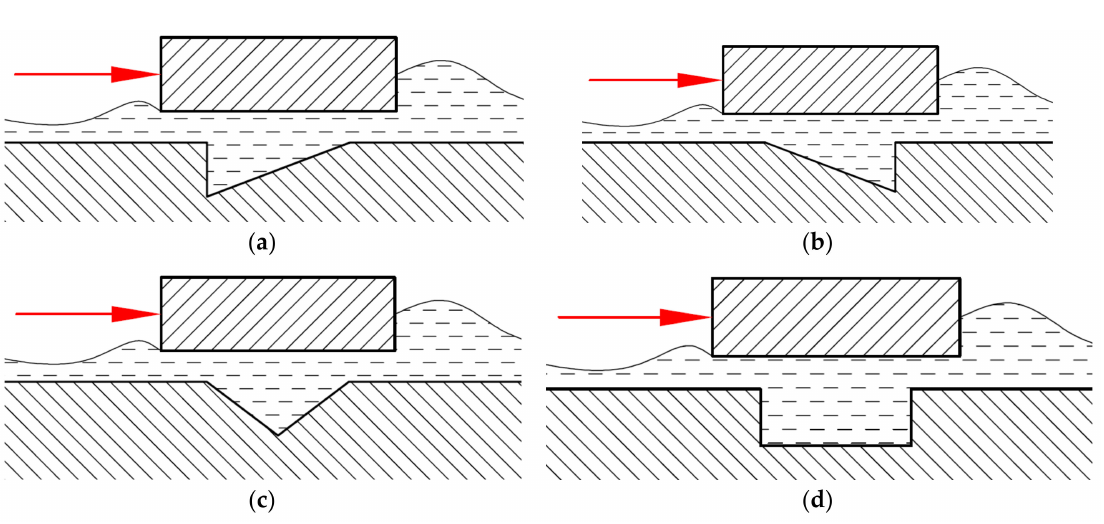
Figure 4. Schemes of bottom profiles of grooves with marked sliding direction of the counter-sample. ( a ) Convergent; ( b ) Dam; ( c ) Both side convergent; ( d ) Both side